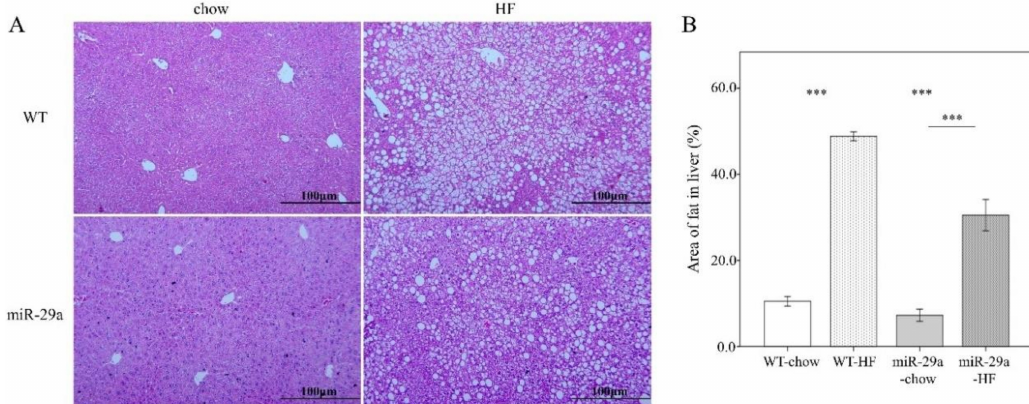
Figure 3. Overexpression of miR-29a reduces hepatocellular steatosis in the context of chronic HFD. Paraformaldehyde-fixed para ffi n-embedded liver tissue was used to determine the abundance of lipid droplets with hematoxylin-eosin (HE) stain. ( A ) Representative HE stain image of each group. ( B ) Lipid droplet area quantified using ImageJ. Data collected from three fields of view of each specimen and six to nine specimens for each group are expressed as mean ± SE. ** p < 0.01 and *** p < 0.001 between the indicated groups. WT, wild type mice. HFD, high-fat diet. miR-29a, mice harboring overexpression of